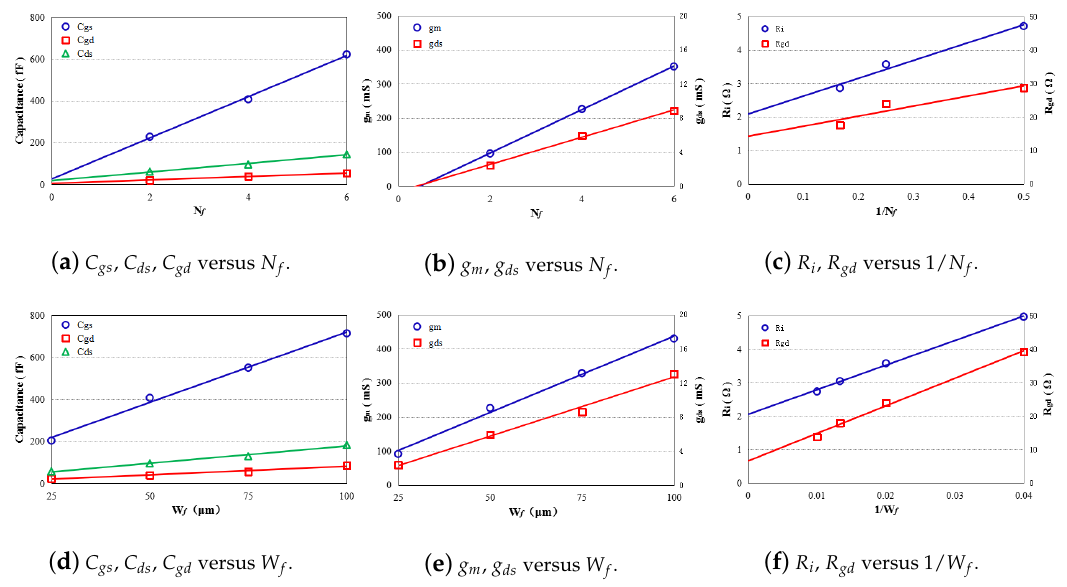
Figure 14. Plots of C gs , C ds , C gd , R i , R gd , g m , and g ds with respect to N f and W f at V ds = 4 V and V gs = 0.55 V, respectively.